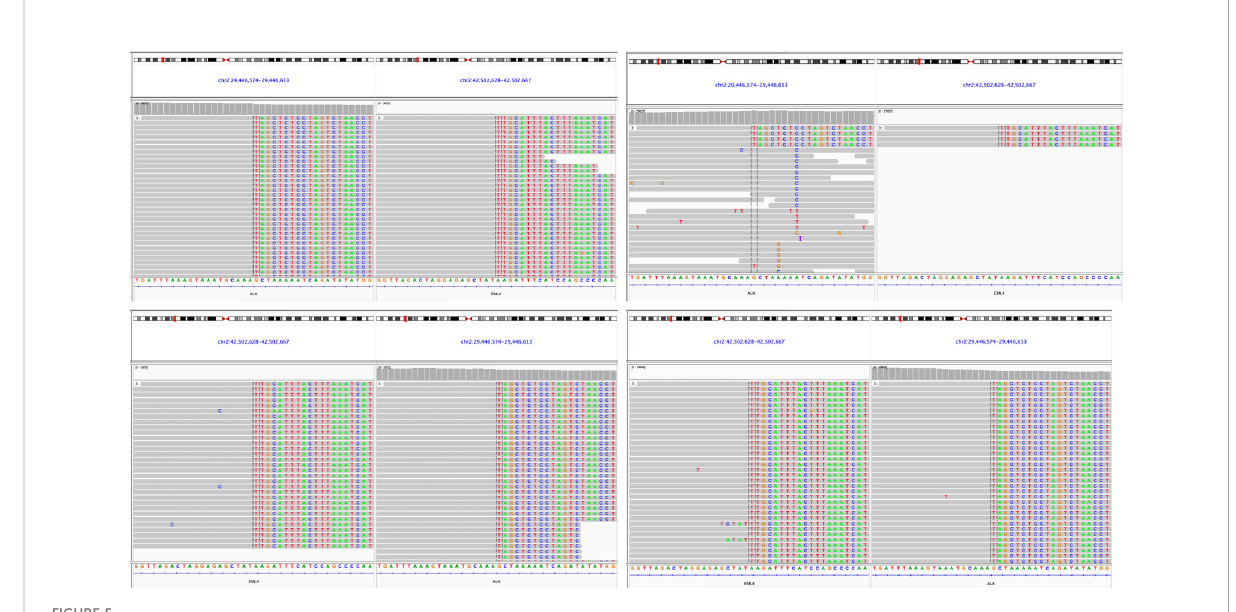
FIGURE 5 Genomic map derived from the biopsied tissue samples of four lung